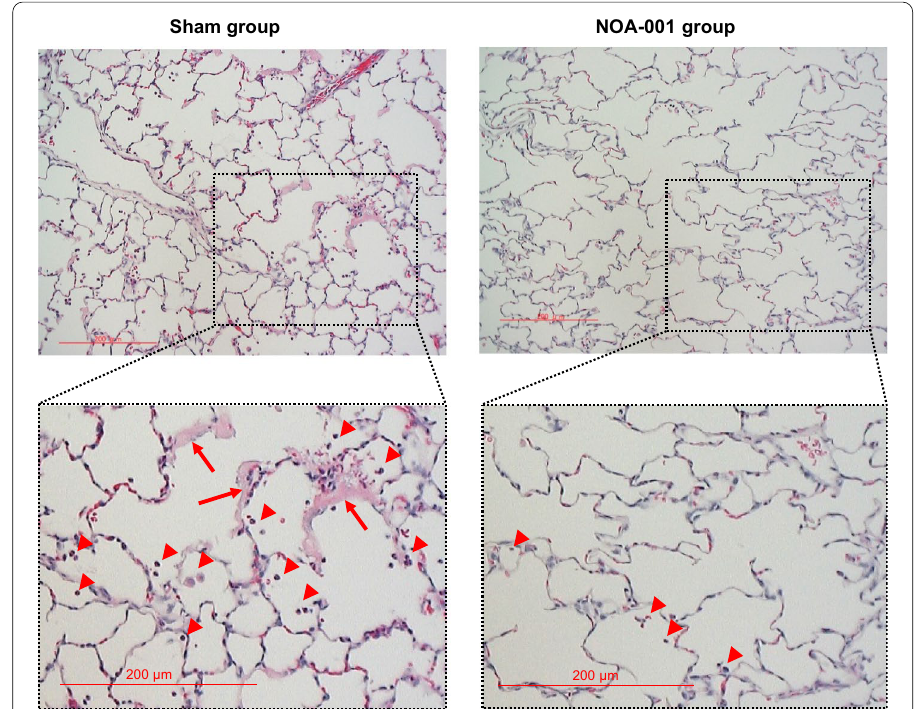
Fig. 4 Histopathological observation of the lung with HE staining at 8 h. Red arrowheads indicate migrated inflammatory cells and red arrows indicate hyaline membranes. Scale bars represent 200